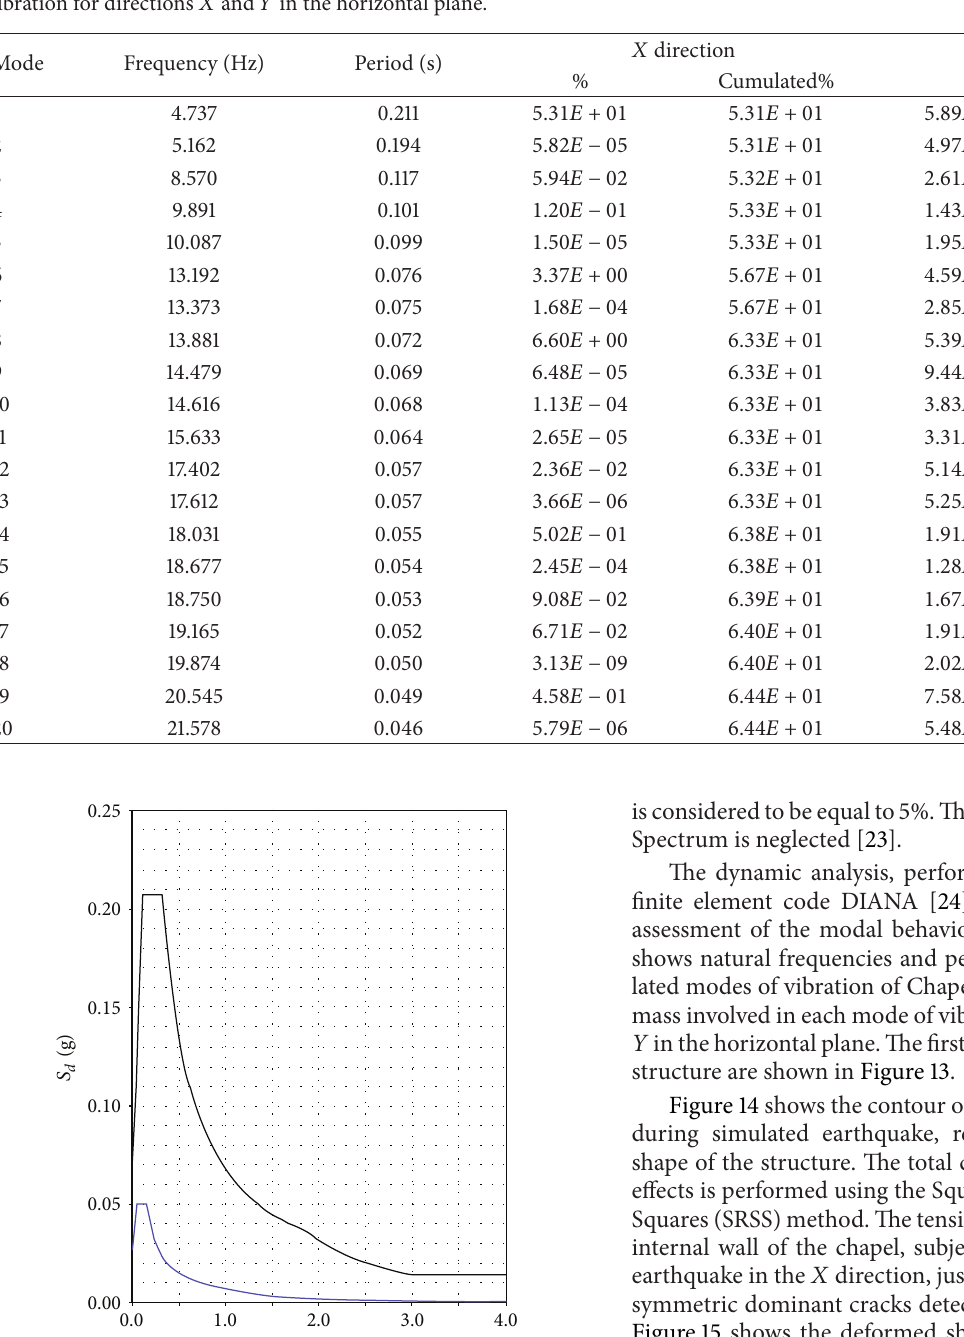
Table 7: Natural frequencies of the first 20 calculated modes of vibration of Chapel XVII and percentages of mass involved in each mode of vibration for directions 𝑋 and 𝑌 in the horizontal plane.